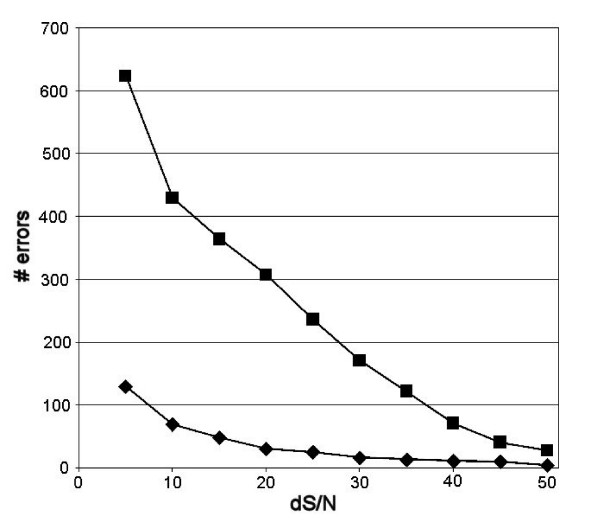
Number of errors at various dS/N cutoffs. The number of errors is the number of incorrect SNP identifications in chimpanzee (diamonds) and gorilla (squares).